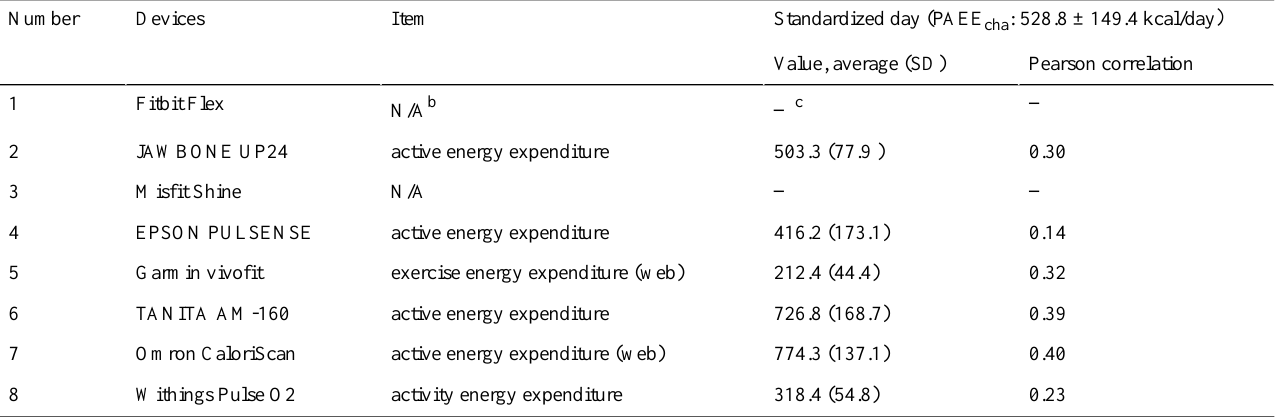
Table 5. The comparison between PAEE a cha and the unique PAEE parameters extracted from each consumer-based wearable